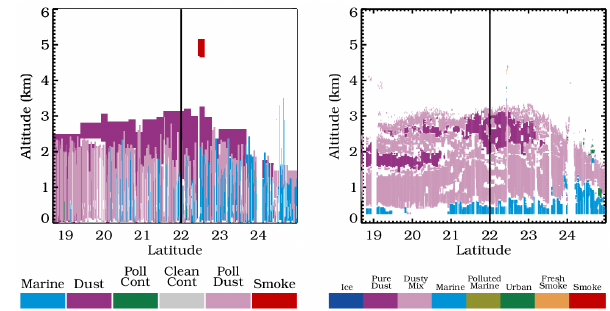
Fig. 4. Aerosol classification masks from CALIOP (left) and HSRL-1 (right) for a nighttime scene in the Caribbean Sea on 26 August 2010. Saharan dust which was advected across the At- lantic Ocean lies above the marine boundary layer. Transit time for HSRL-1 on the B200 was 94min compared to 1.6min for CALIPSO. The point of closest approach is indicated by a vertical line.